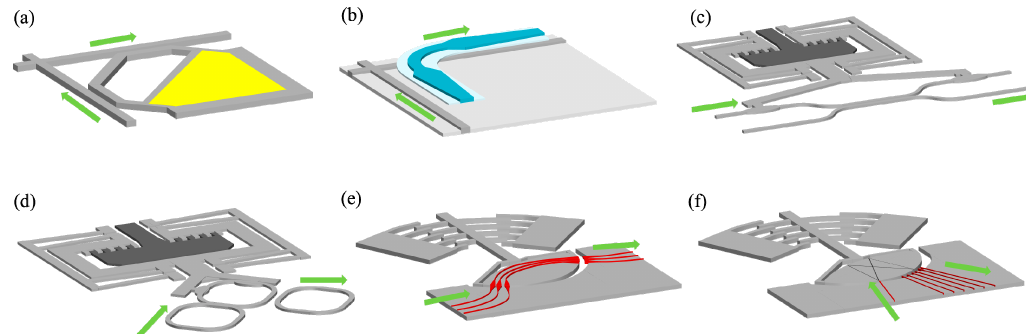
Figure 4. Schematic of ( a ) a switch based on vertically MEMS-actuated directional waveguide coupler ( b ) a switch based on vertically MEMS-actuated adiabatic waveguide coupler ( c ) a switch based on laterally MEMS-actuated directional waveguide coupler ( d ) a switch based on laterally MEMS-actuated MRR ( e ) a switch based on rotationally MEMS-actuated waveguide.